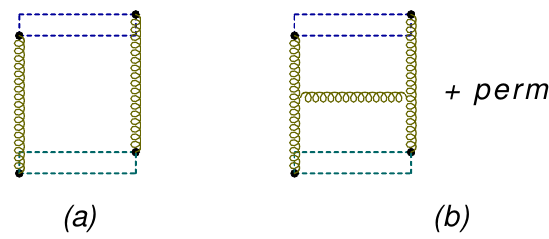
Figure 5 . First (a) and second (b) order diagrams for the correlator of two Wilson